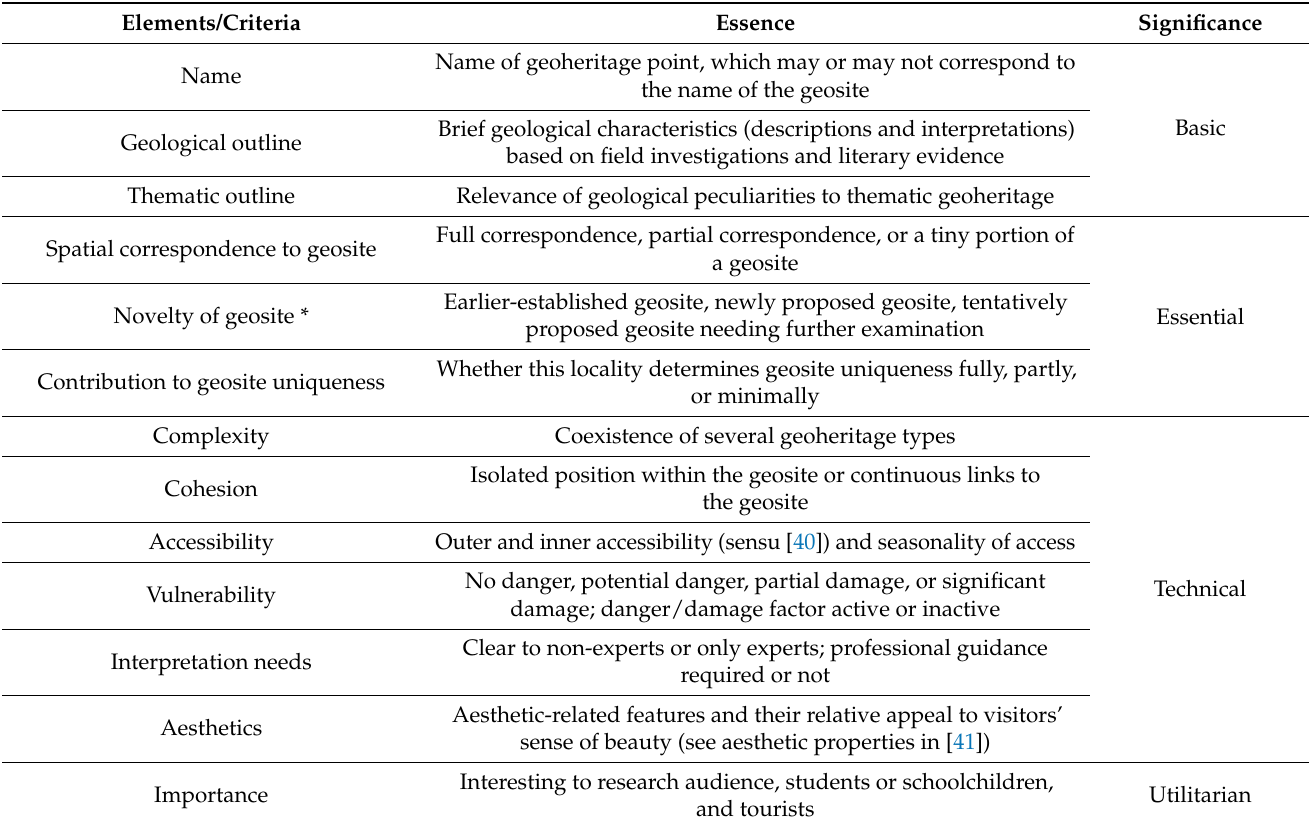
Table 1. Template for characterizing geoheritage